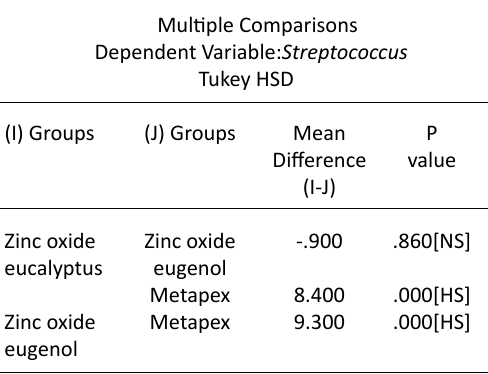
Table 4. Multiple Comparisons of antibacterial effect of various filling materials against Streptococcus